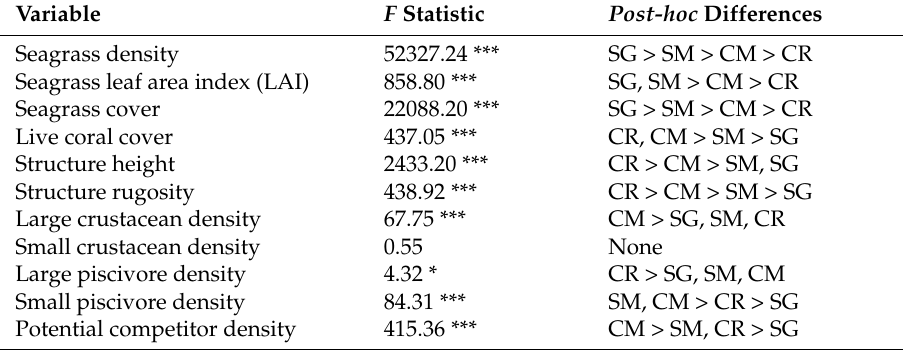
Table 2. Testing the effect of habitat type (n = 4 classifications; see Figure 1.) on select biological abbreviations: Seagrass beds (SG), seagrass-dominated mosaic habitats (SM), coral-dominated mosaic habitats (CM), and coral reefs